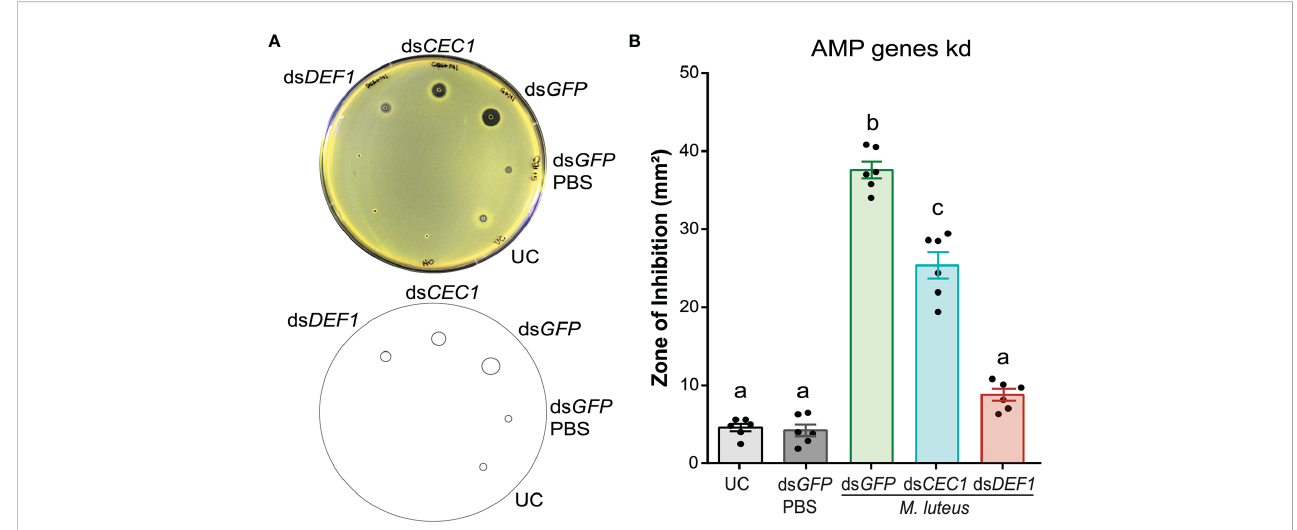
FIGURE 2 Defensin 1 is mainly responsible for the antimicrobial activity against M. luteus . (A) Top: M. luteus -seeded plate showing the zone of inhibition (ZOI) produced by the hemolymph of ds DEF1- and ds CEC1 -injected mosquitoes. The mosquitoes were challenged 48 h after dsRNA injection with E coli , S. aureus , and M. luteus , respectively. Hemolymph was collected 24 h after challenge. Mosquitoes that were uninjected and injected with ds GFP prior to phosphate-buffered saline acted as negative controls. Bottom: Drawing of the plate generated in Fiji is Image J to quantify the ZOI for each treatment. (B) Zones of bacterial growth inhibition (mm 2 ) were measured using customized macros in Fiji is Image J Data are shown as means with ±1 standard error ( n = 6). One-way ANOVA, followed by Bonferroni ’ s multiple-comparison post-test, was performed to calculate the statistical signi fi cance ( P < 0.05). Means with the same letter are not signi fi cantly